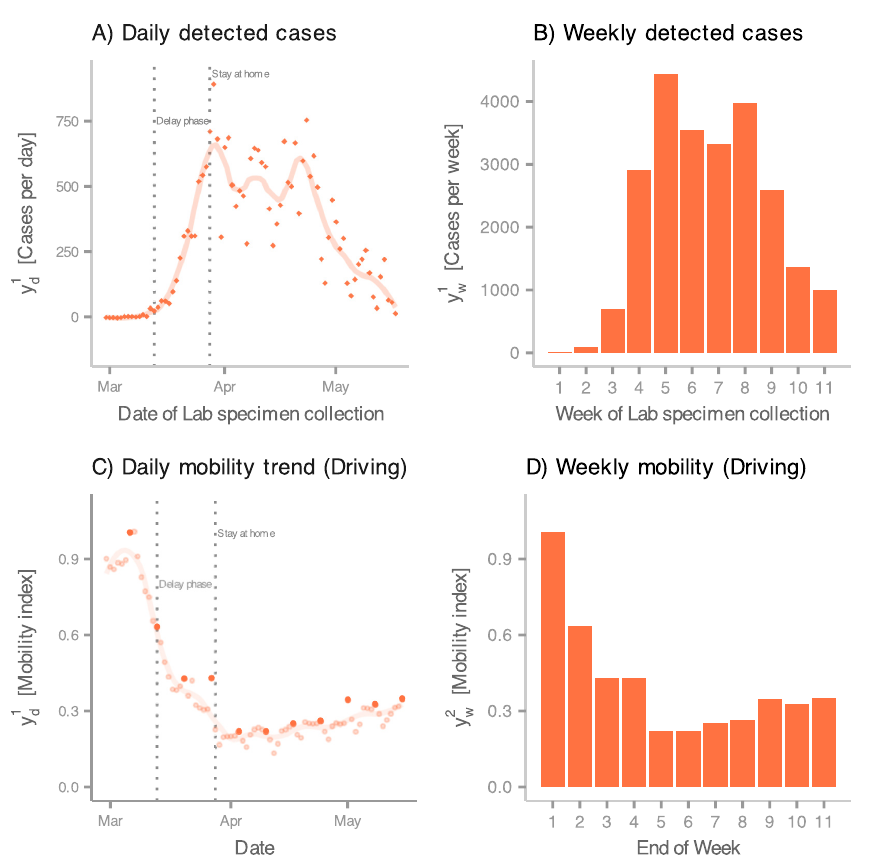
Fig 2. Incidence and mobility data. (A) Daily number (rhombus-shaped points) of COVID-19 cases detected during Ireland’s first wave, from the 29th of February 2020 to the 17th of May 2020. The x-axis indicates the date in which the infected individuals were swabbed. The line represents the smoothed trend (via LOESS method) from the data (B) Weekly number of COVID-19 cases detected in during Ireland’s first wave. The x-axis indicates the number of weeks since the first case was detected. (C) Apple data for Ireland from the 29th of February 2020 to the 17th of May 2020. Points represent the normalised amount of daily requests for driving directions. These indexes are normalised to the value on the 28th of February 2020. We highlight points every 7 days. These highlighted points are used to calibrate DGP1 and DGP2. The line represents the smoothed trend (via LOESS method) from the data. (D) Normalised amount of daily requests for driving directions at the end of each week starting from the 29th of February 2020. These bars correspond to the highlighted points in C.